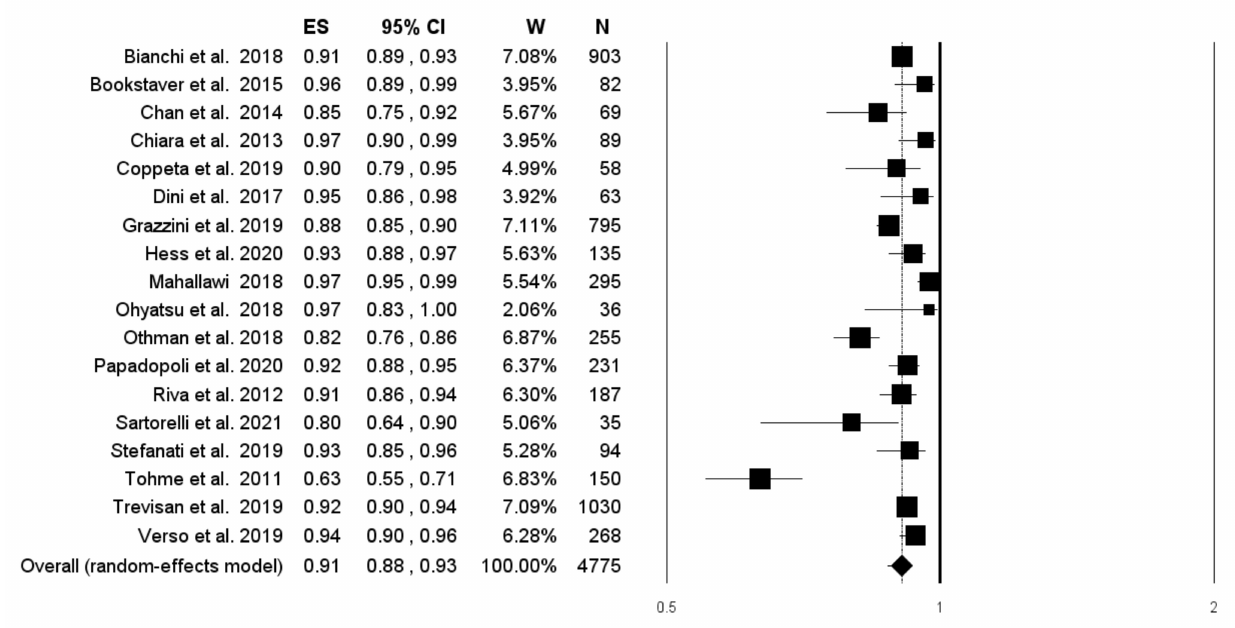
Figure 6. Forest plot of the prevalence of subjects showing an anamnestic response following challenge